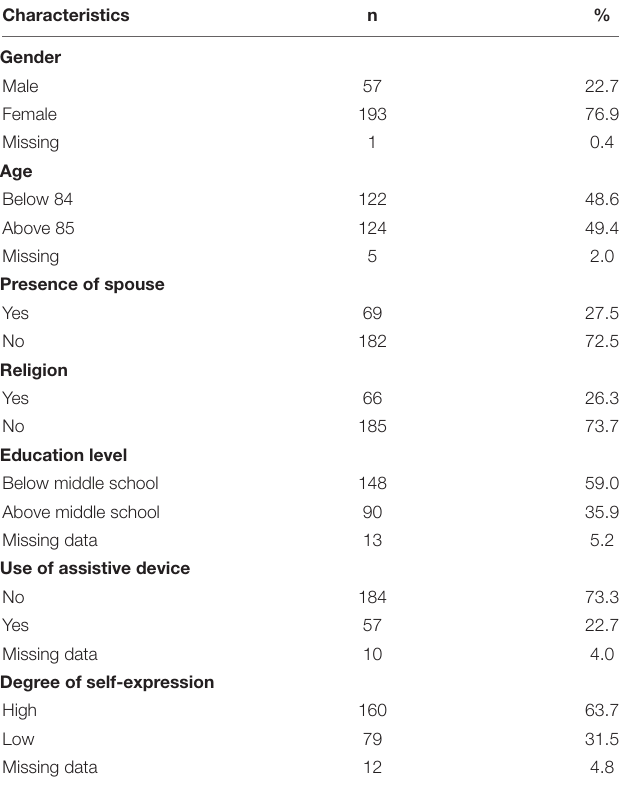
TABLE 1 | Characteristics of patients with dementia ( n =